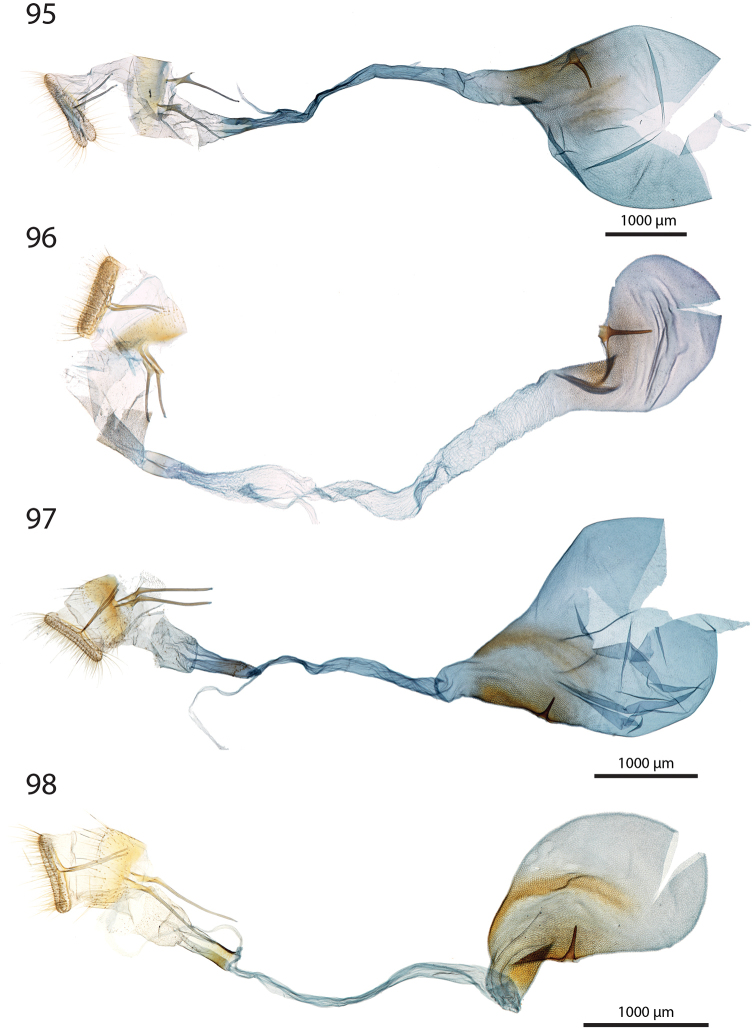
Female genitalia features of Hoploscopa. 95Hoploscopa
marijoweissae sp. nov., paratype, TL709 ♀ 96Hoploscopa
gombongi sp. nov., paratype, TL654 ♀ 97Hoploscopa
pangrangoensis sp. nov., paratype, TL627 ♀ 98Hoploscopa
ypsilon sp. nov., paratype, TL620 ♀.